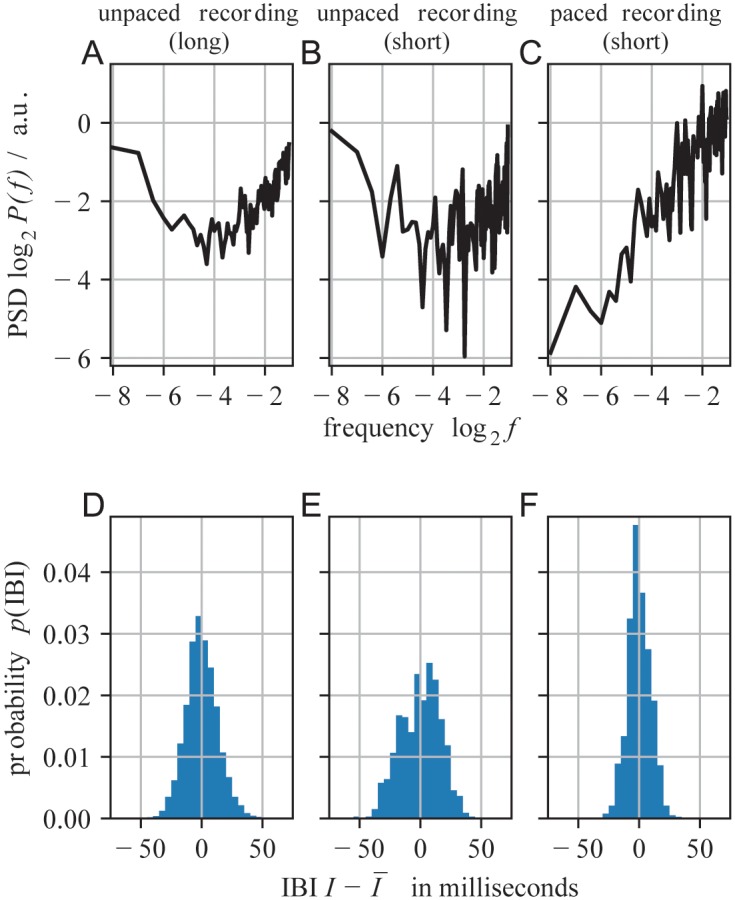
A-C. Power spectral densities (PSD) of inter-beat intervals (IBIs) for unpaced and paced (metronome-guided) recordings. “Long” refers studio drum recordings of about 30 min and “short” to jazz and rock/pop recordings of typically ≈ 3 min (A: long jazz recording; B: Buster Smith—Kansas City Riffs; C: Bee Gees—How Deep Is Your Love). D-F. IBI distribution for the same example recordings.